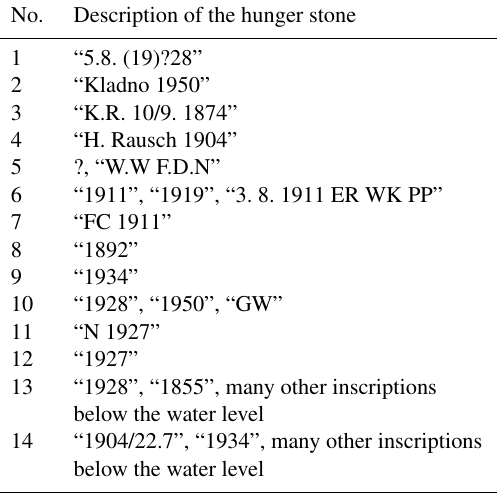
Table 7. Hunger stones detected in Hˇrensko by Randák